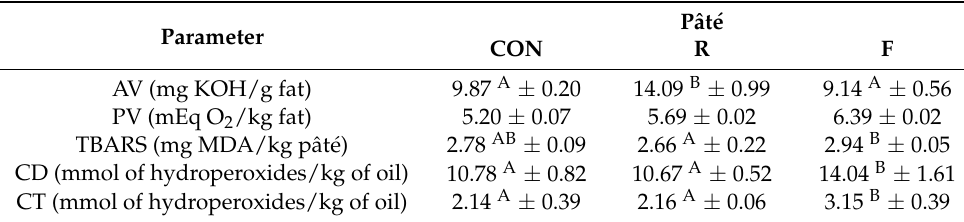
Mean values in rows with different letters differ statistically significantly: A , B — p ≤